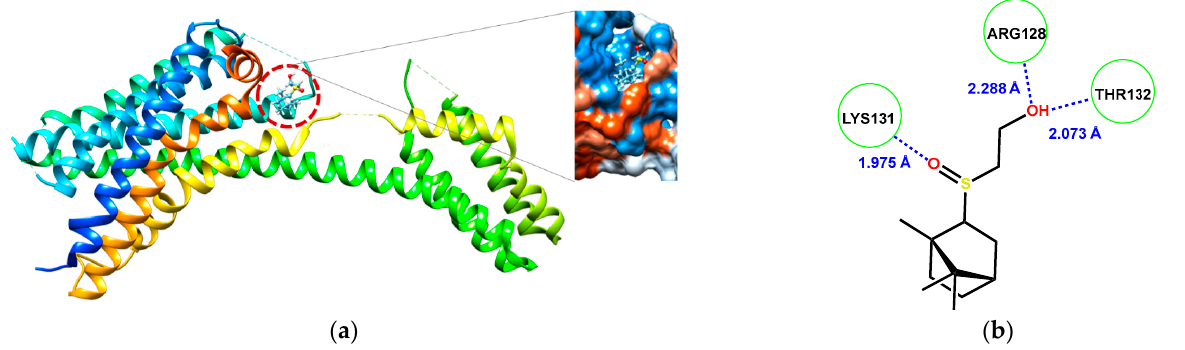
Figure 2. Results of blind molecular docking for the interaction of compound 2 (conformer B) with P2Y 12 . Inset: image of the electrostatic surface of P2Y 12 with bound compound 2 (conformer B) ( a ). Schematic representation of the interaction of compound 2 (conformer B) with the amino acid residues of the binding site in P2Y 12 ( b